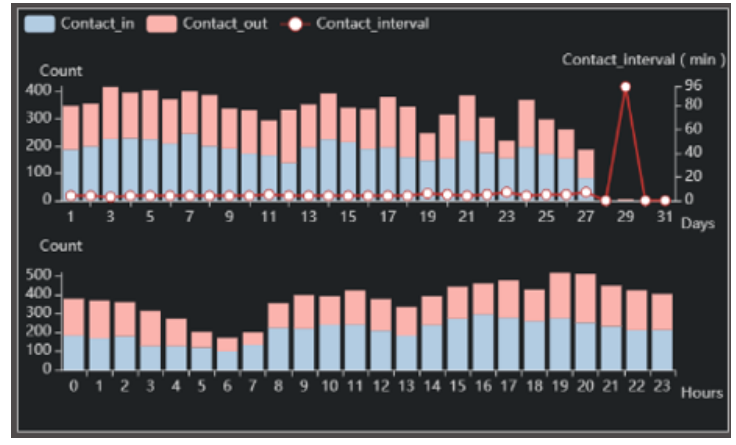
Figure 9. Second ego’s statistical